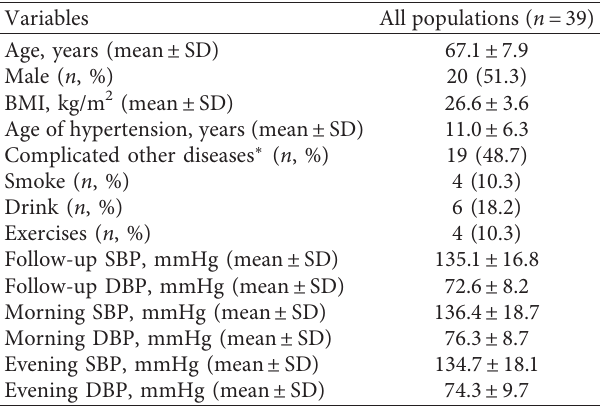
Table 1: Demographic, clinical characteristics, and blood pressure at